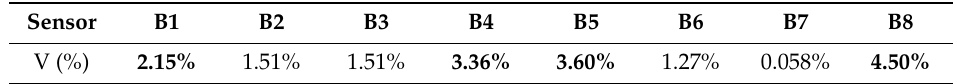
Table 20. The measured concentration volume fraction of deployment scheme based on DE algorithm. Table 21. The measured concentration volume fraction of the rectangular deployment scheme.